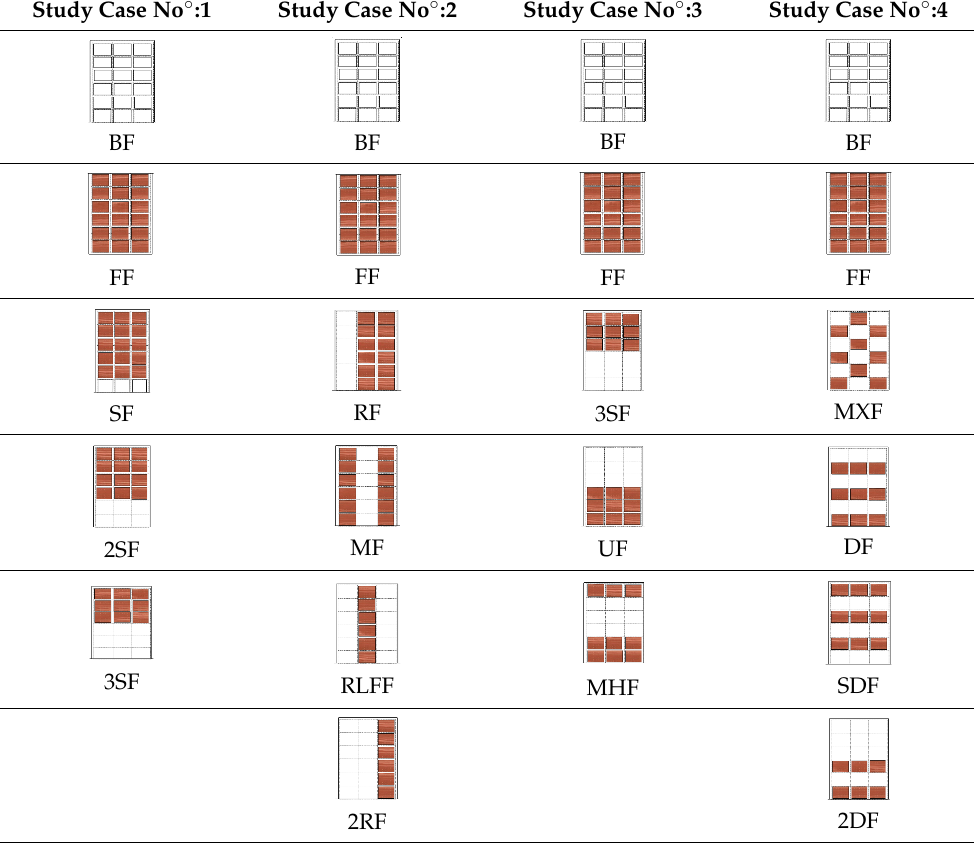
Table 7. Summary of case studies.